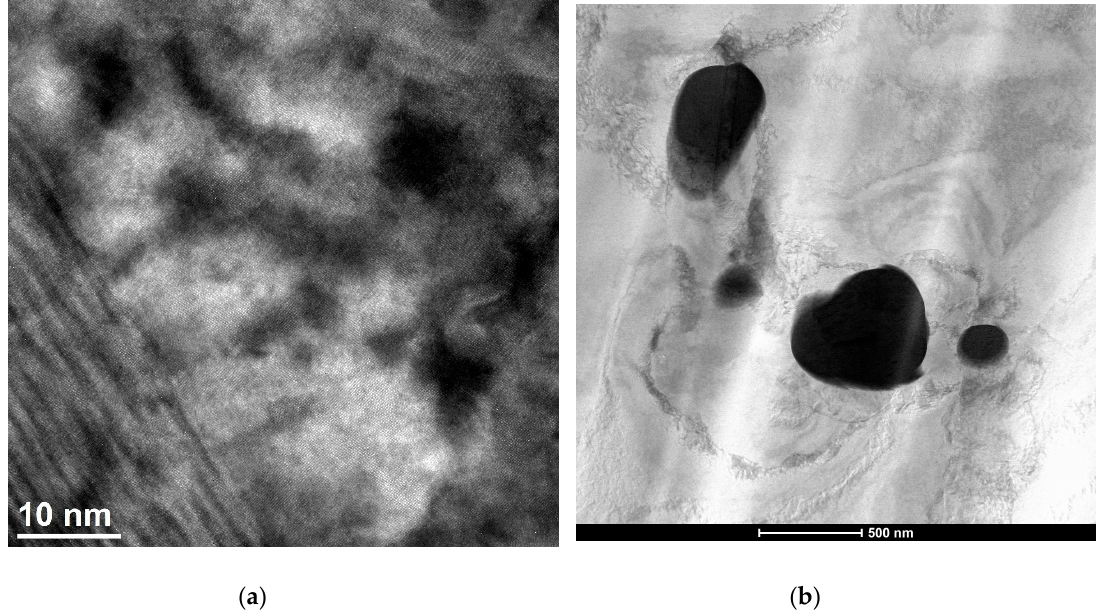
Figure 11. Transmission electron microscope (TEM) structure of Cu–2Ni–1Si–0.6Re alloy, supersaturation 950 °C; time 1 h, water cooling; plastic deformation 50%; ageing 450 °C 1 h ( a ), Re phase ( b ).